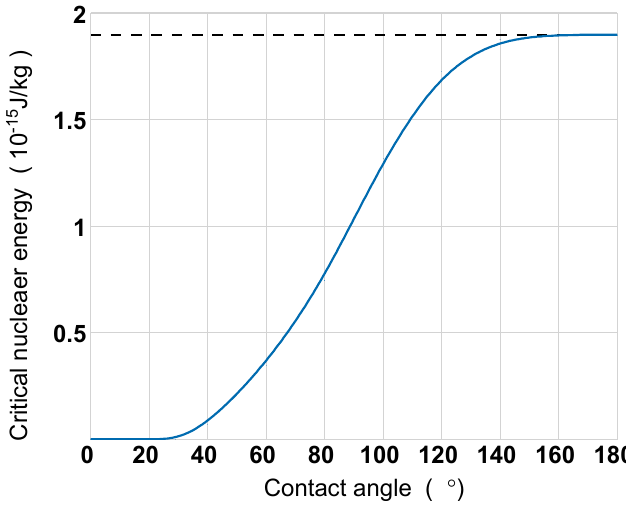
Figure 3. Effect of contact angle on nucleation.